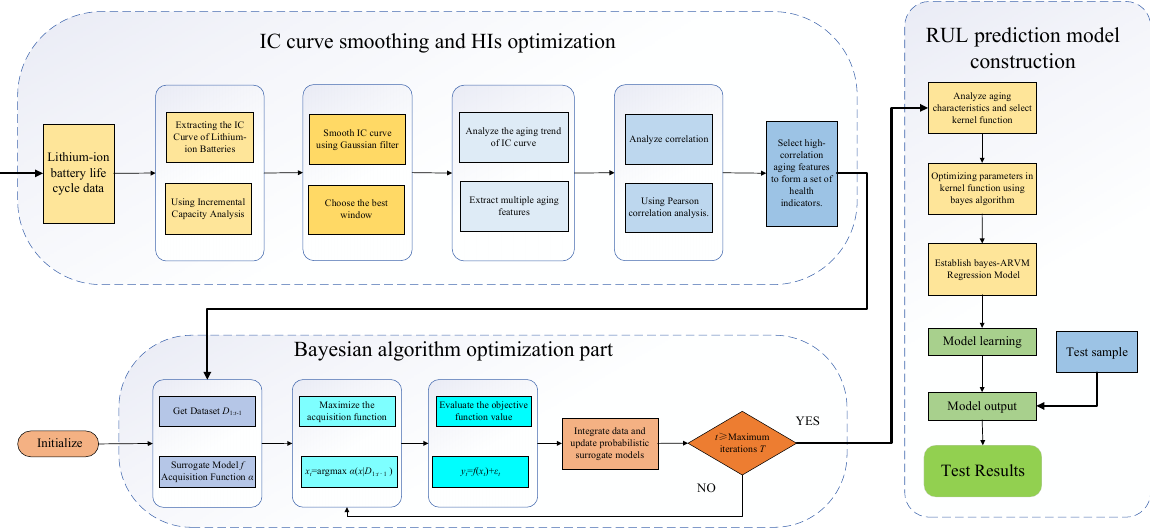
Figure 7. Flow block diagram of adaptive RVM model based on Bayesian algorithm optimization